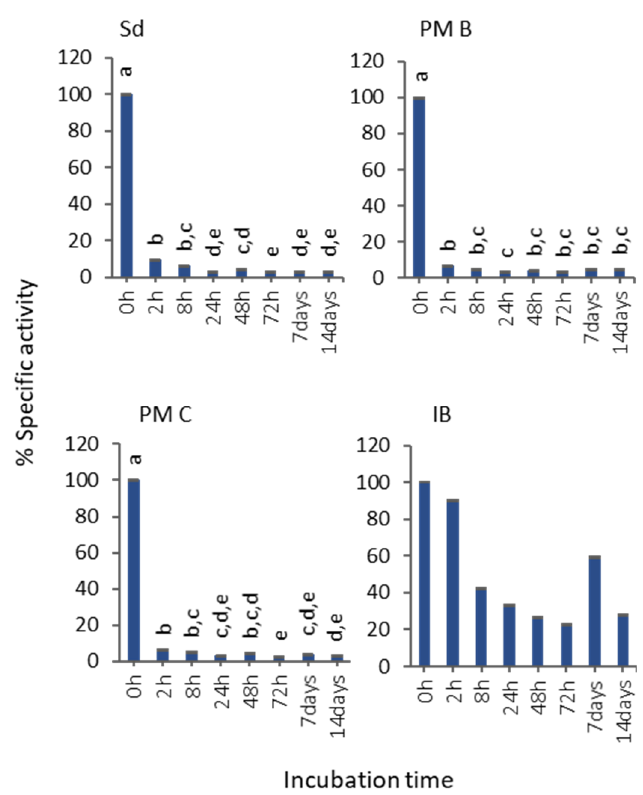
Figure 3. Evolution of the MMP-9 activity at different time points of incubation in serum 50% ( v / v ). Non-transformed means and transformed SEM are represented. Data were analyzed, using a fixed effect model, with format as a fixed effect. Different letters depict significant differences: solubilized MMP-9 (Sd), p < 0.0001; non-covalent MMP-9-nanopolymers (PM B), p = 0.0023; covalent MMP-9-nanopolymers (PM C), p < 0.0001; MMP-9 IBs (IB), p = 0.84.